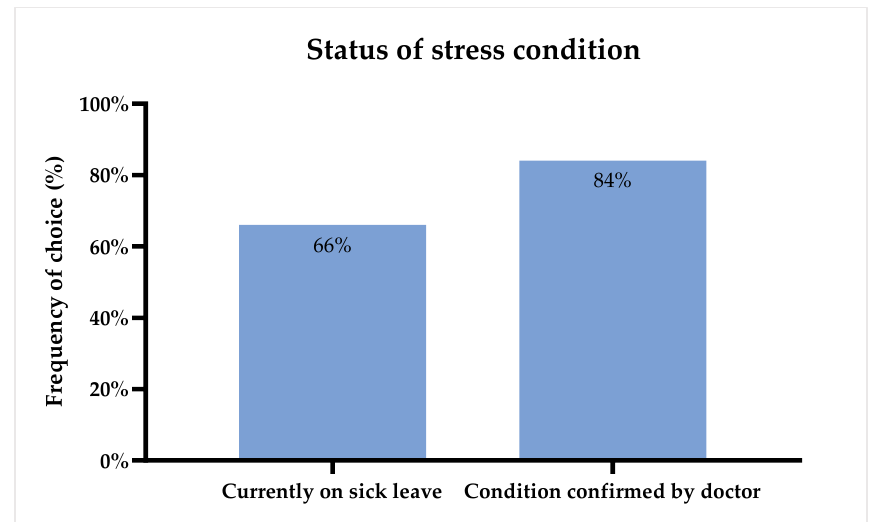
Figure 1. Self-reported status of condition of stress illness for all respondents ( n = 190).